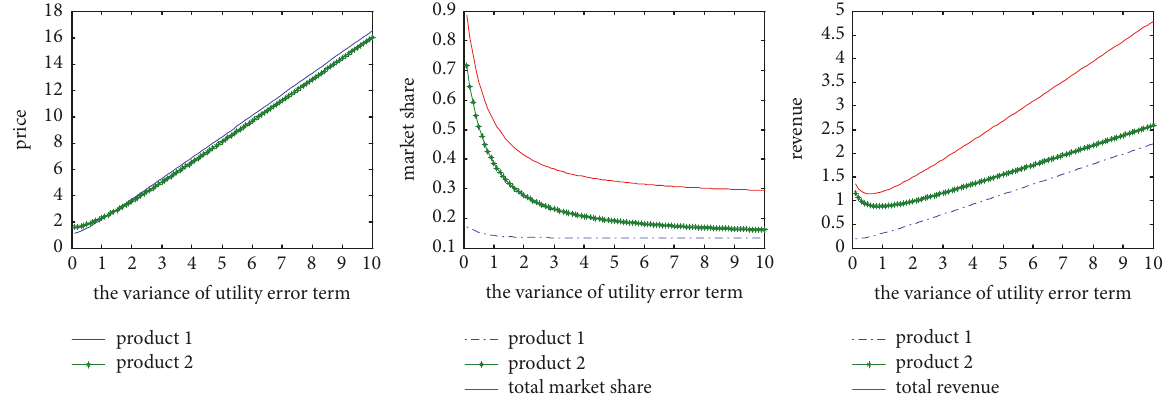
Figure 8: The influence of the variance of utility error term on the optimal